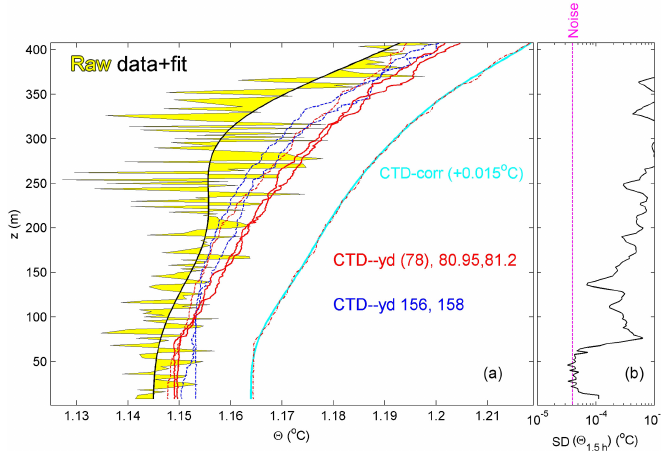
Figure B1. Conservative temperature profiles with depth over the lower 400ma.b. (a) 1-day mean moored sensor data, raw data after calibration (thin black line, yellow filled) and smooth high-order polynomial fit (thick black solid line). In red are three CTD profiles within 1km from the mooring during the first days of deployment (two solid profiles on day 80–81 coincide in time with moored data mean), and in blue dashed are two CTD profiles after recovery of the mooring. The mean of the two solid red profiles is given by the red dashed-dot profile, 0.015 ◦ offset for clarity, with its smooth high-order polynomial fit in light blue to which the moored data are corrected. (b) Standard deviation of 1.5h T-sensor data between days 80.26 and 80.32 when the layer between about 15 and 50ma.b. is nearly homogeneous. The sensor noise level is indicated by the purple line.